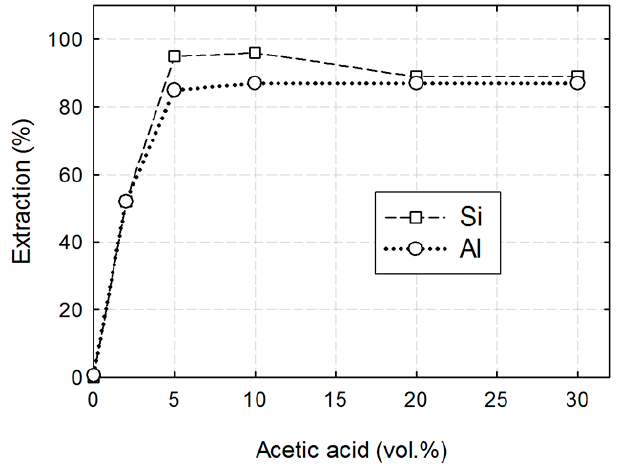
Figure 2. Extracted levels of Si and Al as functions of acetic acid concentration.